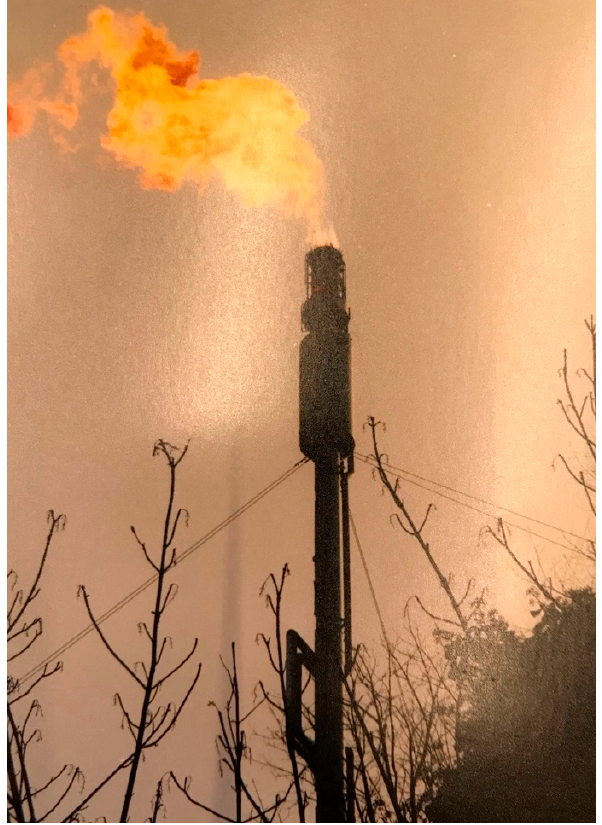
Figure 6. Of the flame on the refinery (Photo Credit: Lorelai Thomas).